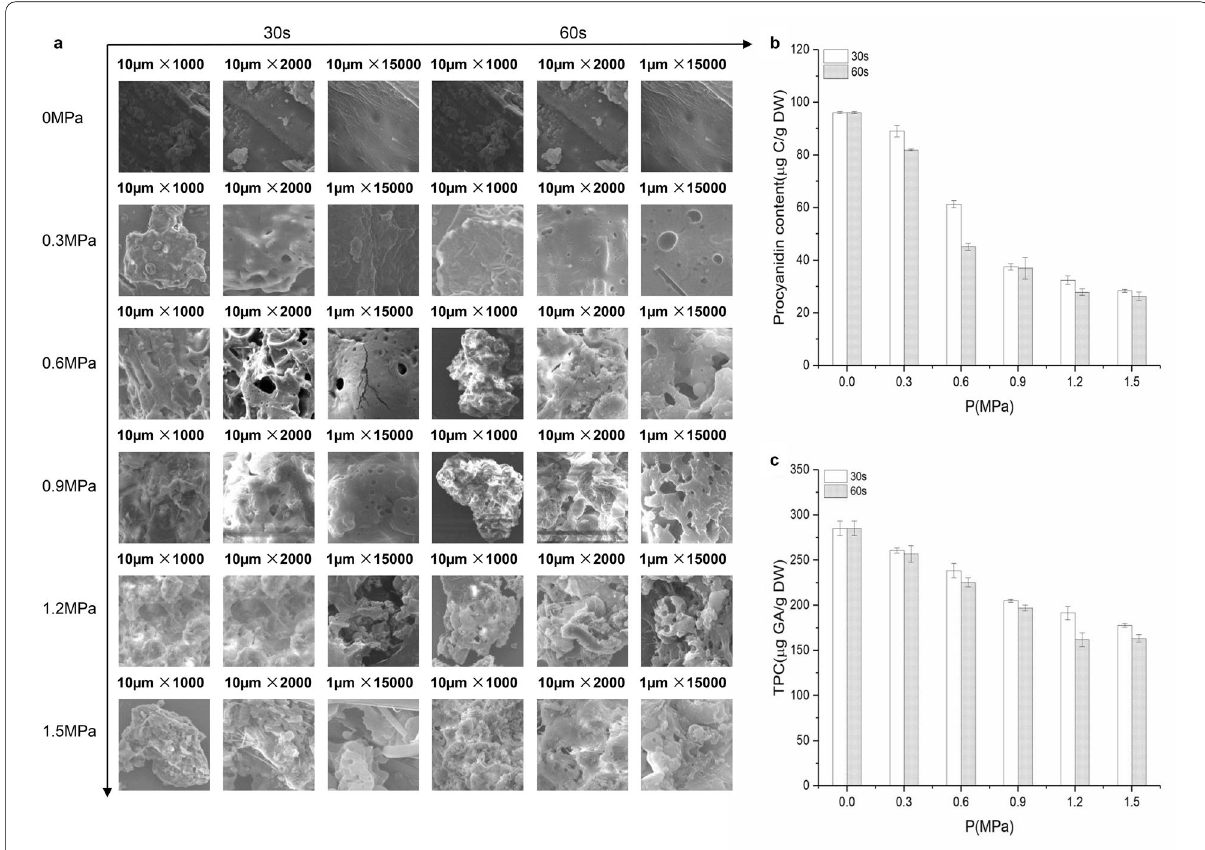
Fig. 1 Structural and chemical changes after SE treatment. SEM images of the unexploded and exploded samples via SE treatment with different times and pressures ( a ). Effect of SE treatment on the procyanidins content ( b ) and total phenolic content ( c